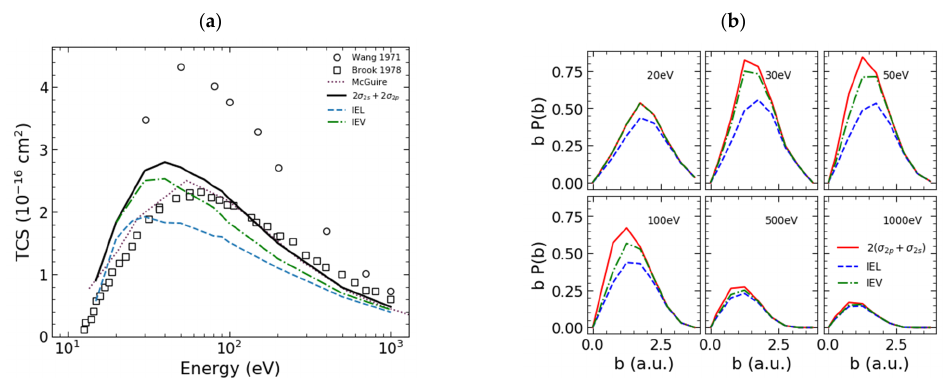
Figure 2. Total ionization cross-section as a function of the impact energy for collisions of electrons with carbon atoms. Expt: dots- Wang and Crawford (Ref. [2]), squares: Brook (Ref. [3]). Theories: dashed-red-line: TIDW, dotted-dashed-blue-line: TDCC, short-dashed-green-line: RMPS, all from Ref. [8]; short-dotted-pink line: BSR [9], solid-blue-line: Peach [4,5], solid-orange-line: Omidvar [6], dotted-magenta-line: McGuire [7], solid-black-line present CTMC results using the standard addi- tion rule.